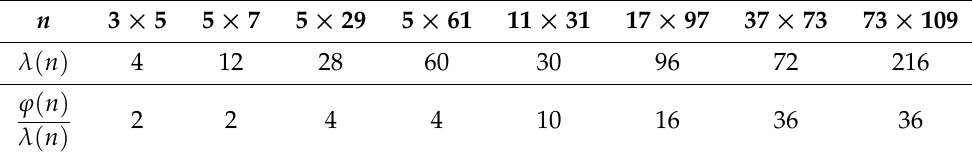
Table 1. Comparison between Carmichael and Euler functions for the product of two primes.